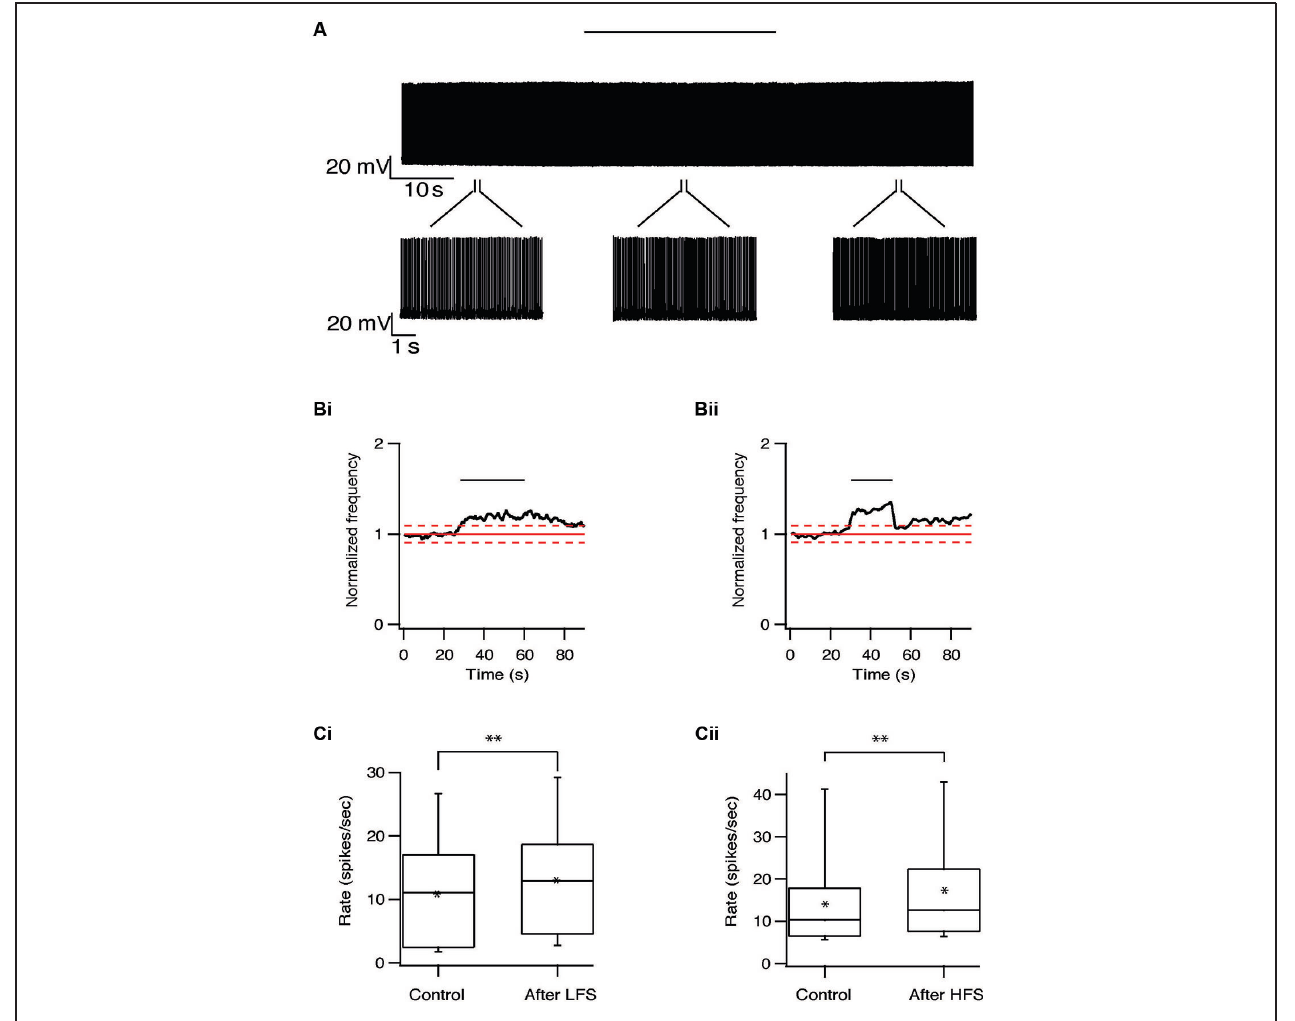
FIGURE 8 | Long-term excitation in the GP induced by repetitive stimulation. (A) Representative recording from a pallidal neuron during 10 Hz stimulation of the STN. Stimulation artifact was removed to improve visualization of the neuronal activity. Horizontal line above indicates period of stimulation. (B) Changes in normalized population